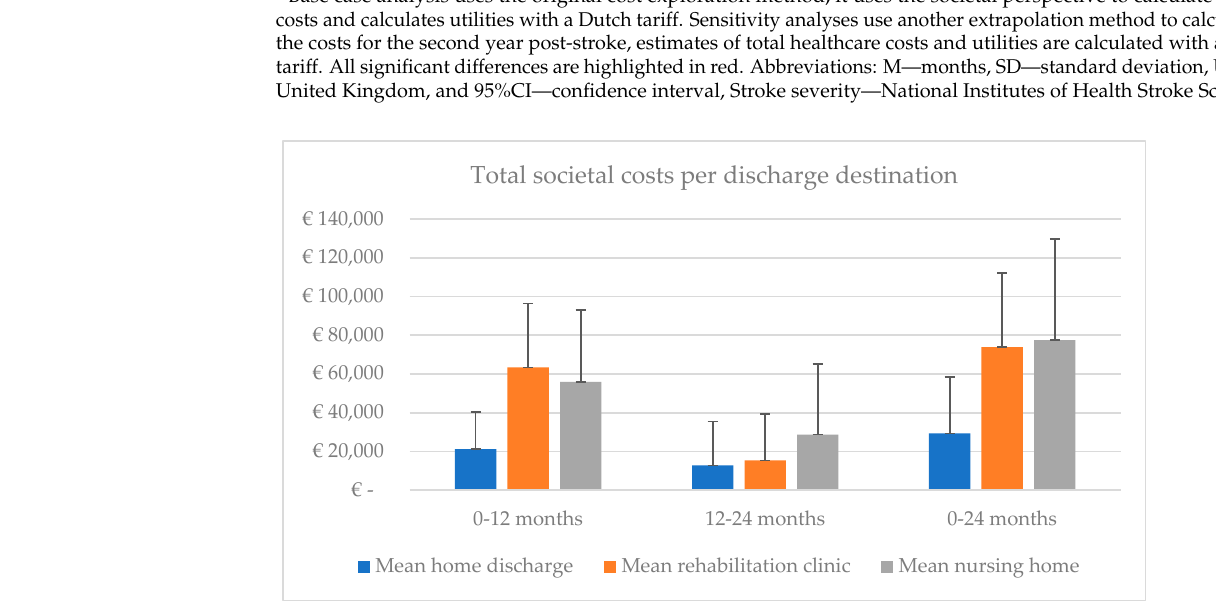
( B ) Figure 2. ( A ): subgroup analyses: mean (standard deviation) costs for discharge group, home (n = 247, in blue) and rehabilitation clinics ( n = 48, in red), or Nursing home ( n = 49, in grey). ( B ): subgroup analyses: mean (standard deviation) costs per NIHSS scores, 1–4 (in blue) and >5 (in red). NIHSS—National Institutes of Health Stroke Scale. 4. Discussion